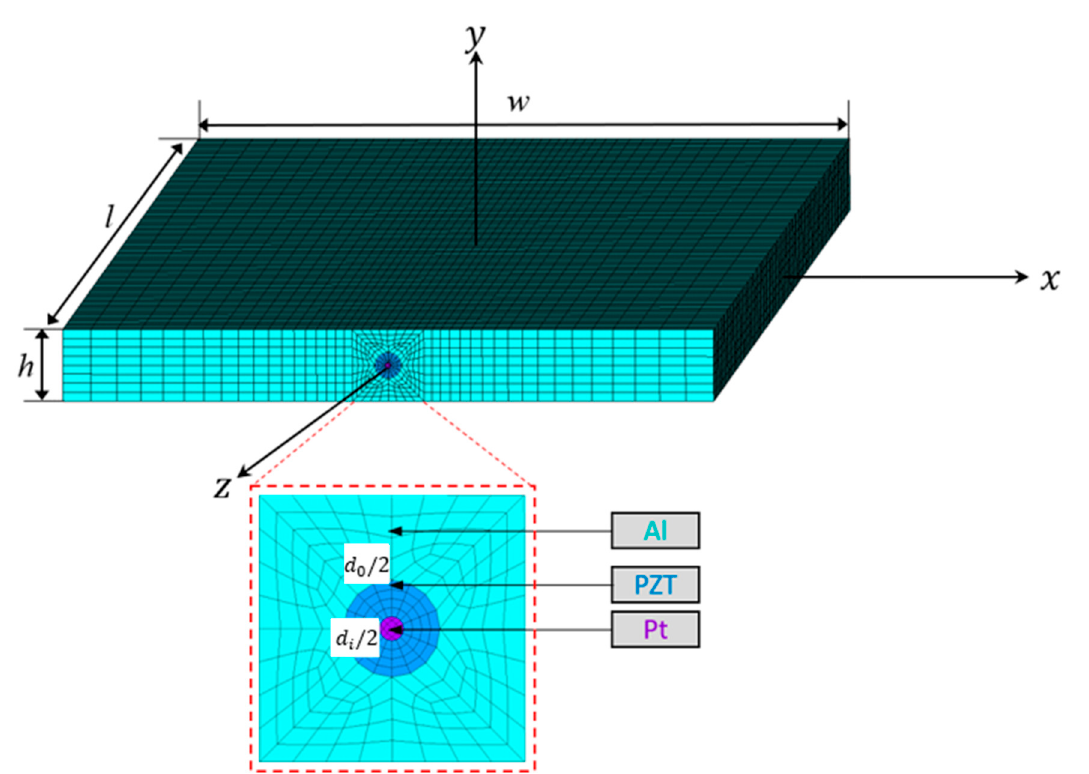
Figure 1. Finite element analysis model of lead zirconate titanate (PZT) piezoelectric fiber/Al composite.